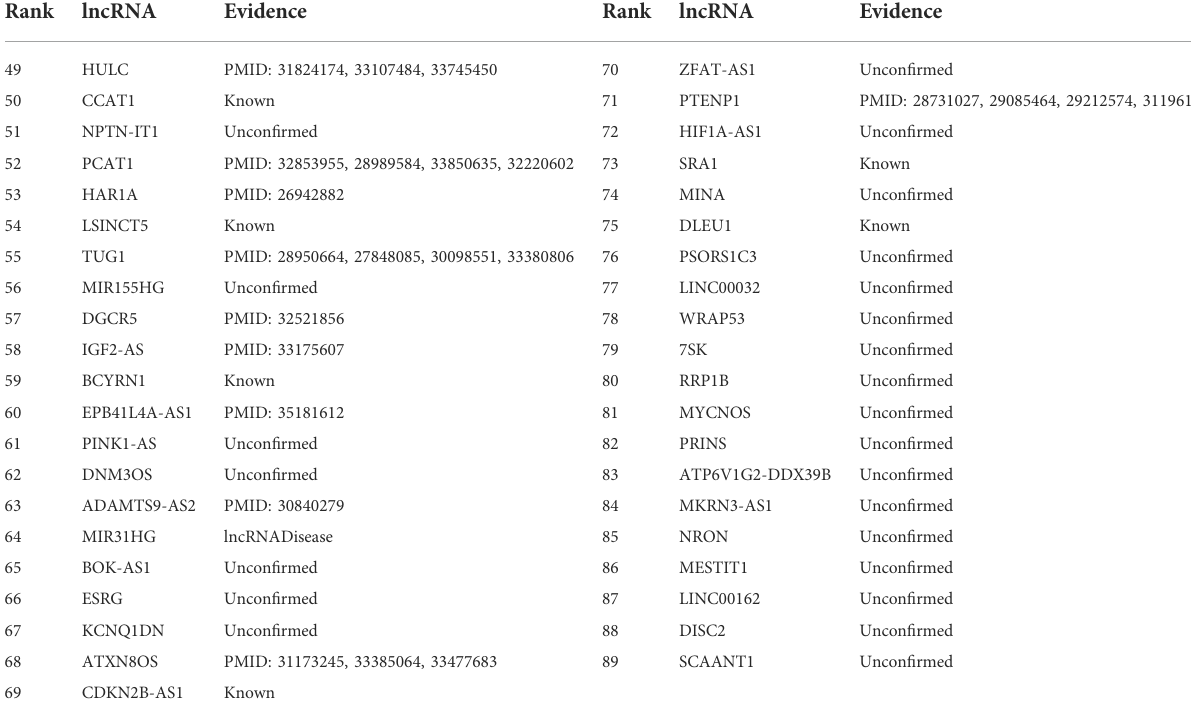
TABLE 3 The rankings of the remaining 41 lncRNAs according to association with breast cancer on the MNDR dataset.